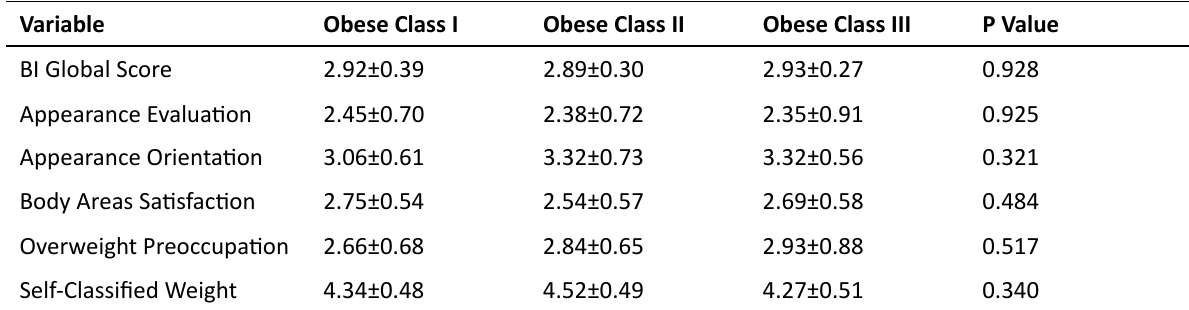
Table 2. ANOVA, Comparison of Body Image among different obese category Variable